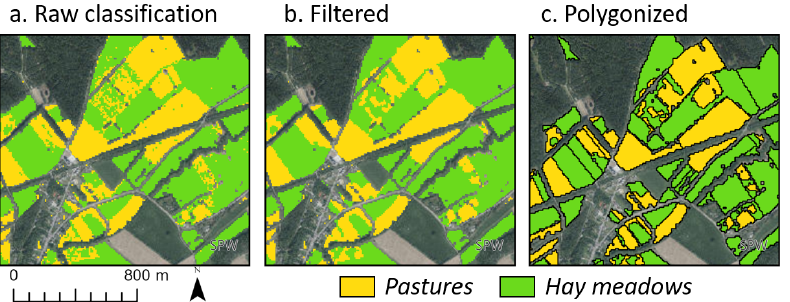
Figure 9. Post-processing of the raw classification result ( a ). Filtered to remove isolated pixels ( b ), polygonized and cleaned to remove small parcels ( c ).